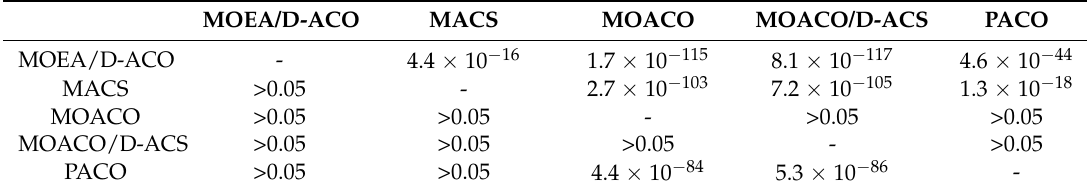
Table 11. Kruskal–Wallis test on kroAB200 based on